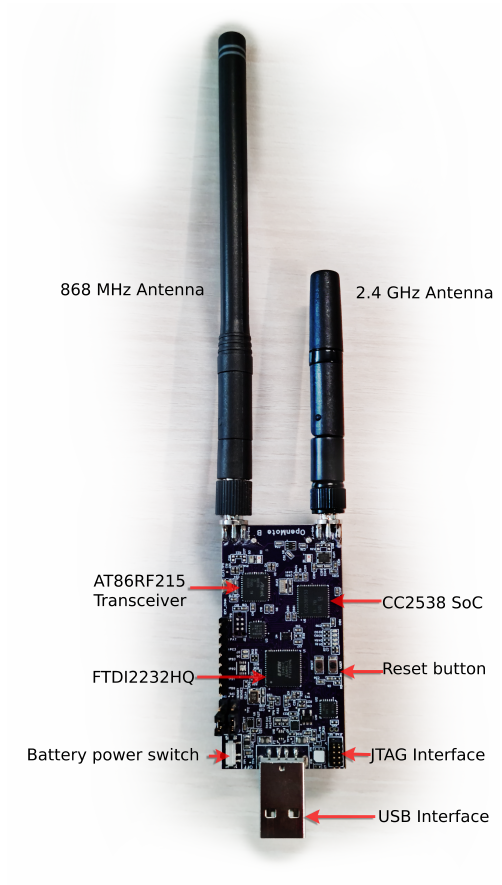
Figure 4. The OpenMote Bused in parts of the